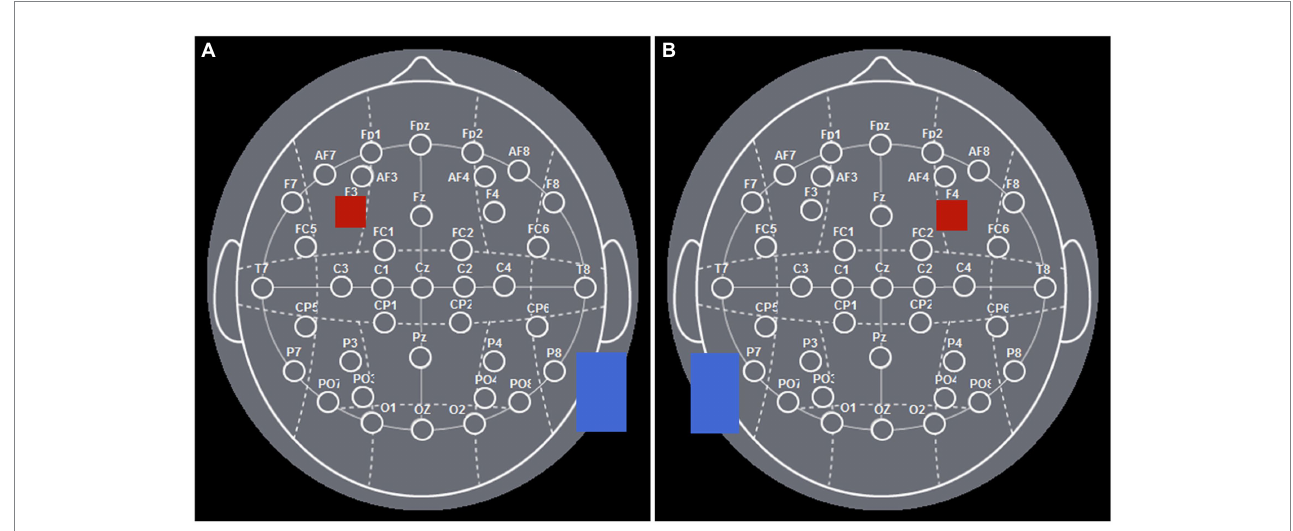
FIGURE 2 The electrode positions of DLPFC. (A) The electrode positions of left DLPFC. (B) The electrode positions of right